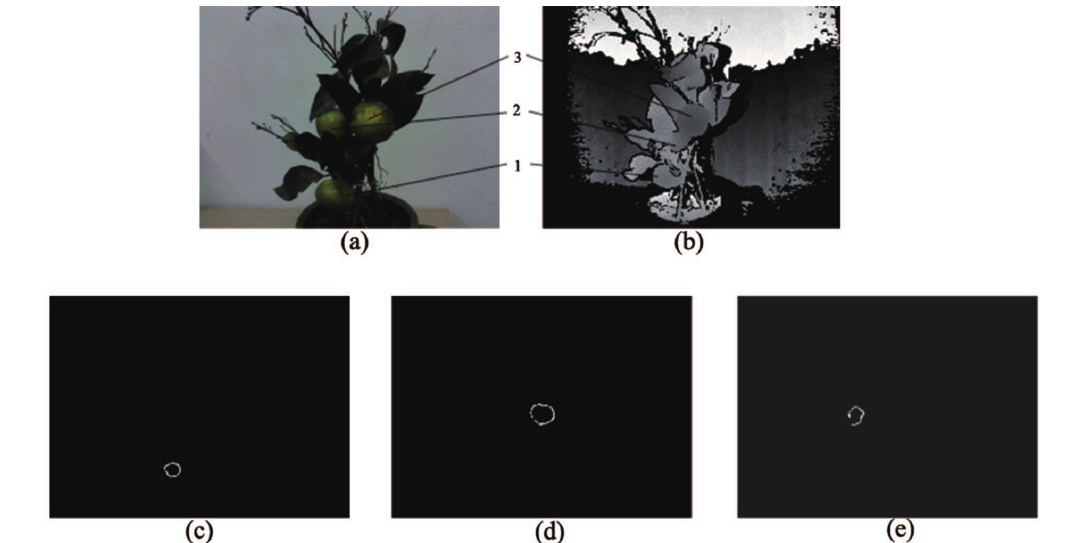
Figure 20. Successful fruit intersection curves in a complex environment: ( a ) complex on-branch environment; ( b ) depth image; ( c ) intersection curve of Fruit 1; ( d ) intersection curve of Fruit 3; ( e ) intersection curve of Fruit 2.